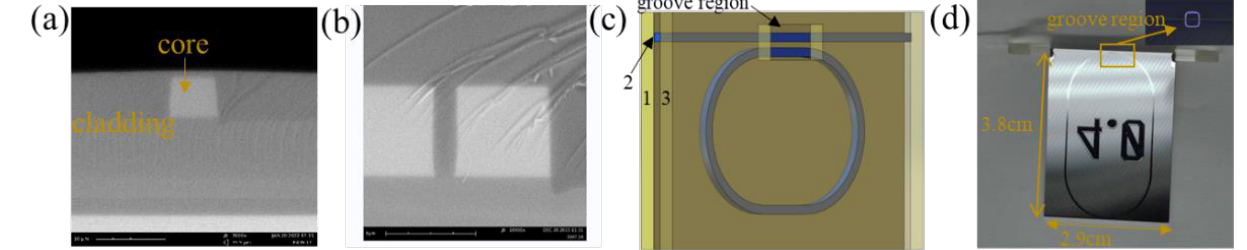
Figure 1. ( a ) SEM image of the cross-section of groove region. ( b ) SEM image of the cross-section of a region without groove. ( c ) Schematic illustration of ring resonator structure: layer 1 and layer 3 are silica cladding layers, and layer 2 is a germanium-doped silica core layer. ( d ) Digital photo of the ring resonator.